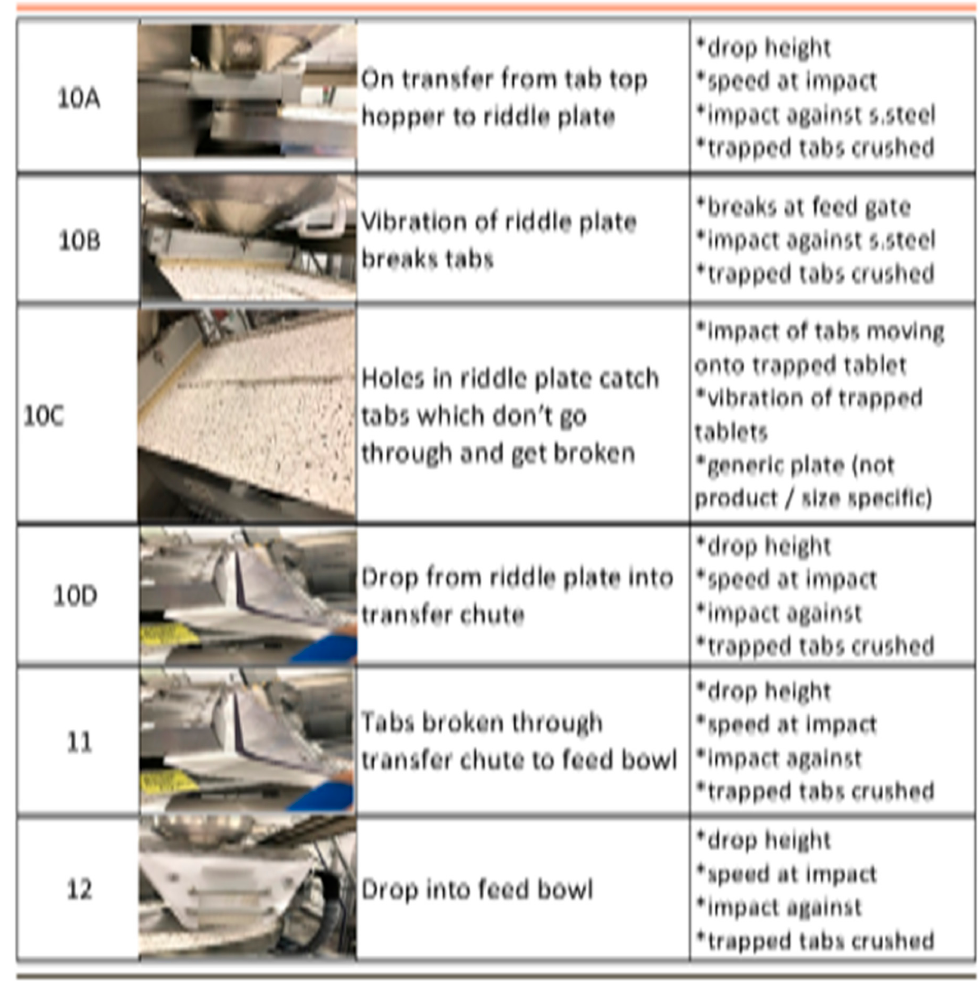
Figure 15. Entry to the Feed Hopper process operation steps and the associated failure modes that can occur at each step.